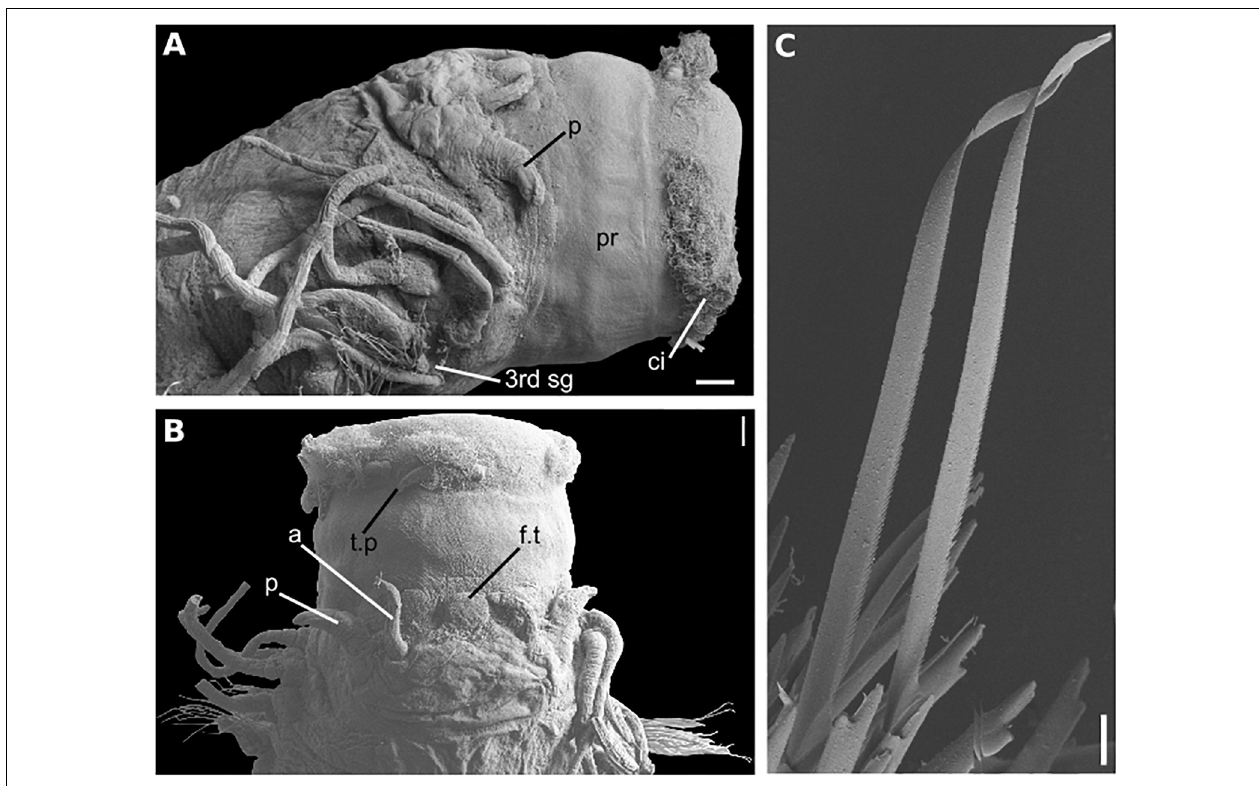
FIGURE 11 | Sirsoe nadir sp. nov. (A) anterior end, lateral view; (B) anterior end, dorsal view; (C) neurochaetae from median neuropodia. Abbreviations: 3rd sg: third segment; a, lateral antenna; ci, ciliation; f.t, frontal tubercle; n.o, nuchal organs; p, palps; pr, proboscis. Scales: (A,B) : 100 µ m; (C) : 20 µ